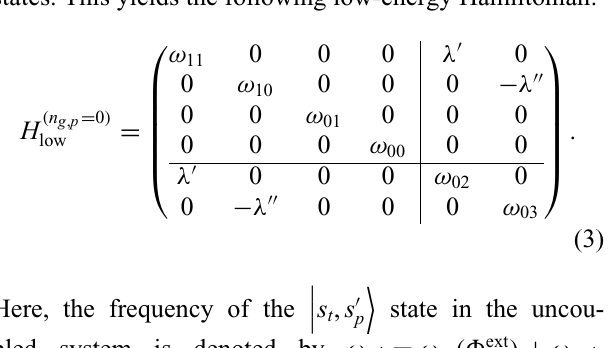
FIG. 2. The low-energy spectrum of the hybrid qubit setup and the CZ φ gate. (a) The low-energy spectrum of the hybrid qubit setup for n g , p = 0 and ( E J , t , E J , p , E C , t , E C , p , E C , c ) = 2 π( 12, 2.7, 0.2, 0.18, 0.025 ) GHz as a function of the external flux (cid:6) ext of the tunable transmon. The CZ φ gate is realized by a rapid excursion from (cid:6) ext = 0 to the vicinity of the = (cid:6) ∗ (cid:6) . The bottom panel shows the coupling strengths, g yz and g zz , upon approaching the anticrossing. (b) The same as (a) but ext ext for n g , p = 0.5. Each energy level shown is now exactly twofold